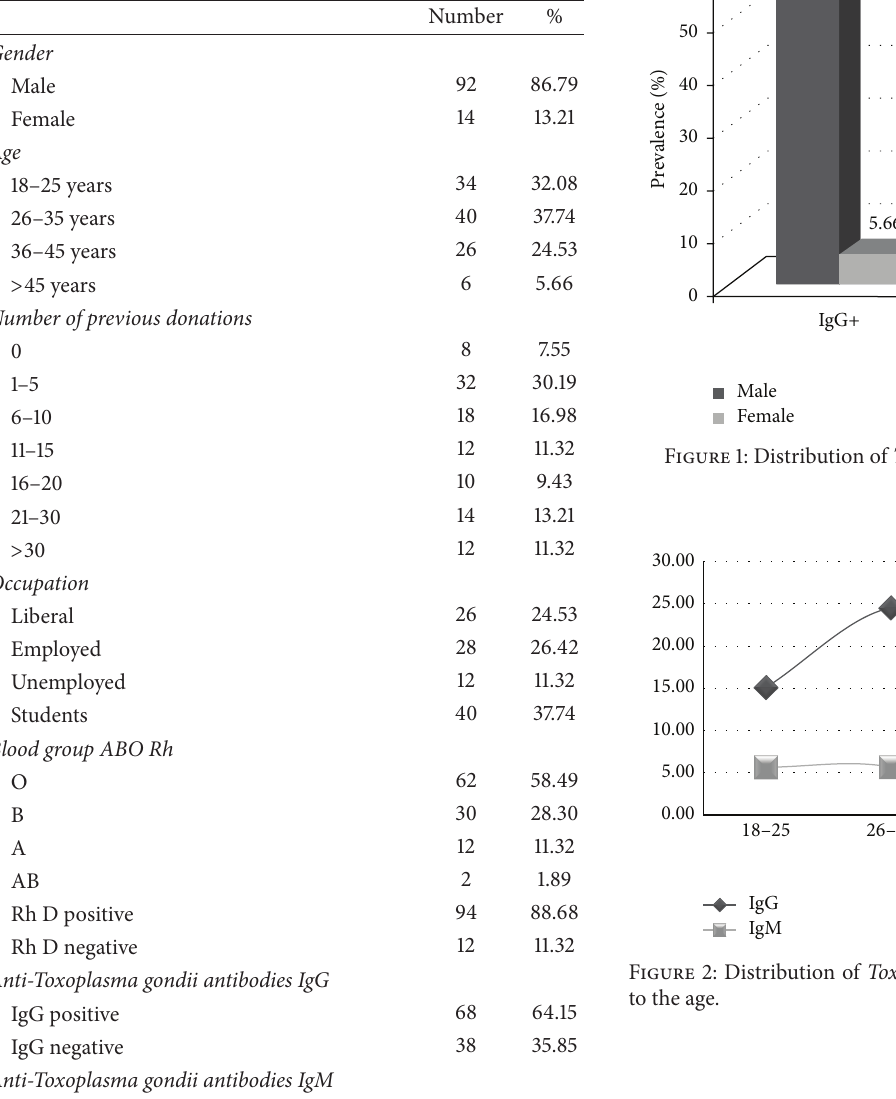
Table 1: Distribution of donors according to demographic charac- teristics.